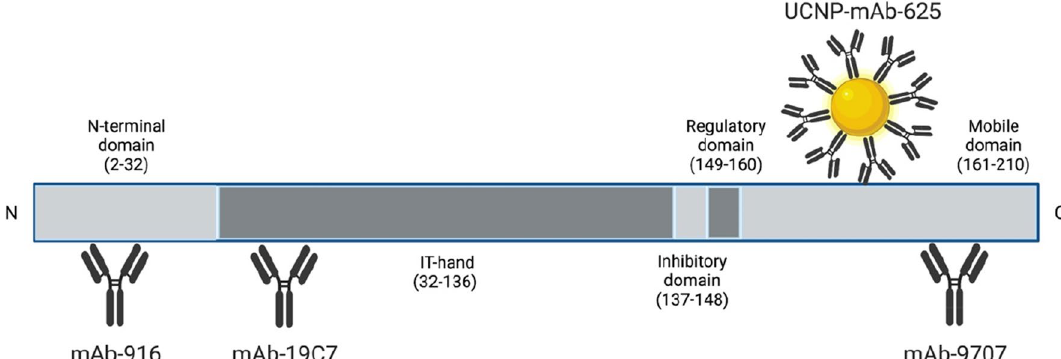
Figure 5. A schematic illustration of the cTnI epitopes and the binding sites of the antibodies in the developed LFIA. The developed UCNP-LFIA utilized the (3 + 1) assay design, with three capture antibodies against the N -terminus, midfragment and C-terminus of cTnI and one tracer antibody against the C-terminus of cTnI molecule. Created with www. BioRe nder.